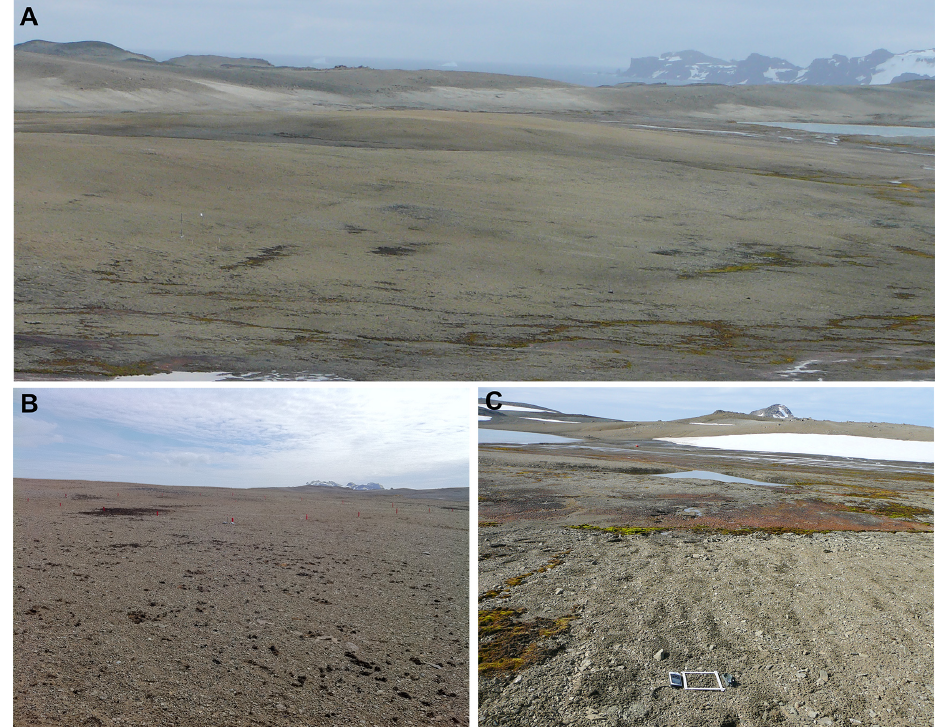
Figure 2. (A) Picture of the area in which the CALM site is located on the SW flank of Limnopolar Lake, in a smooth and gently sloped (<2%) terrain without vegetal coverage. The surface is characterized by fine to coarse materials (B) , sometimes organized into patterned grounds, with the presence of ponds and small moss patches (C)